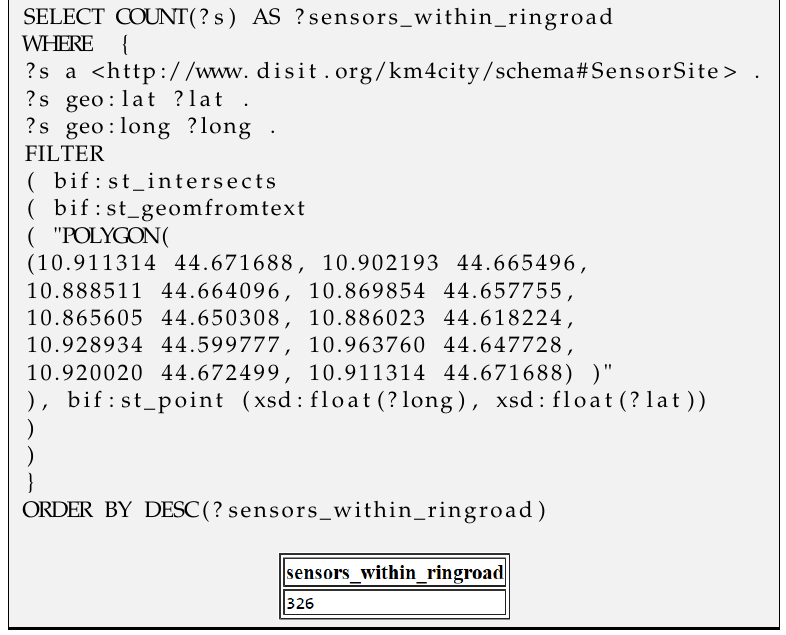
Figure A5. GeoSPARQL query showing the number of sensors in Modena located inside the area delimited by Modena’s ring